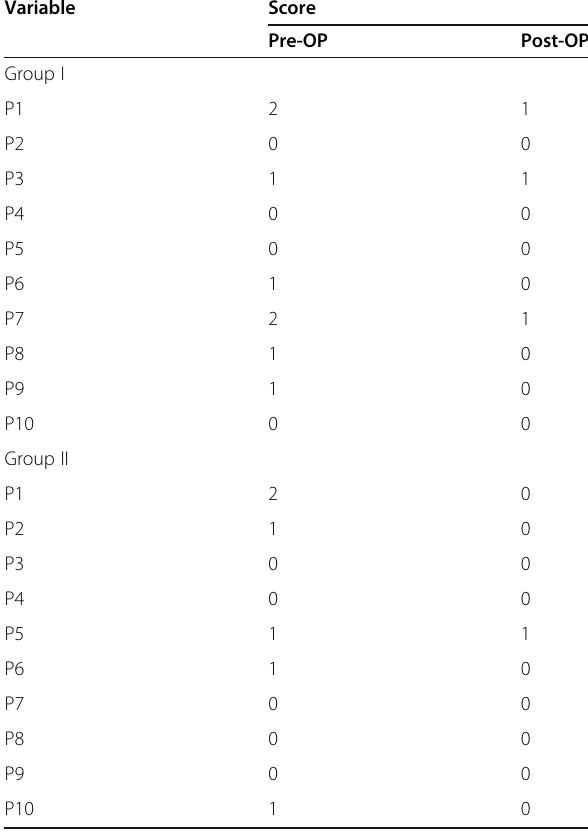
Table 3 TMJ Clinical Symptoms Score. If a patient had symptoms corresponding to TMJ-related pain, noise, or limitation of mouth opening before and after surgery, 1 point was assigned to each symptom to calculate a score. Group